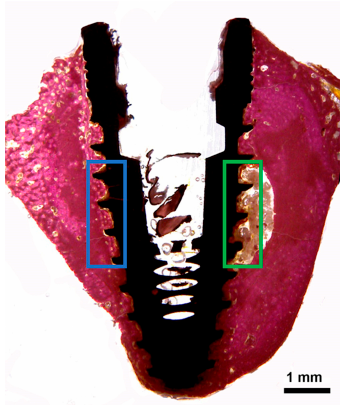
Figure 4. Schematic image to show the areas in the center of the implants that were evaluated by descriptive method. The blue rectangle represents side 1 (implant near the cortical bone), and the green rectangle represents side 2 (implant in contact with the medullar bone portion).